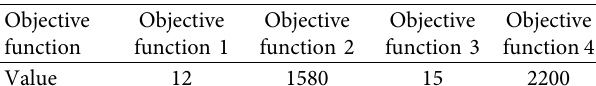
Table 5: Optimal answer of objective functions.